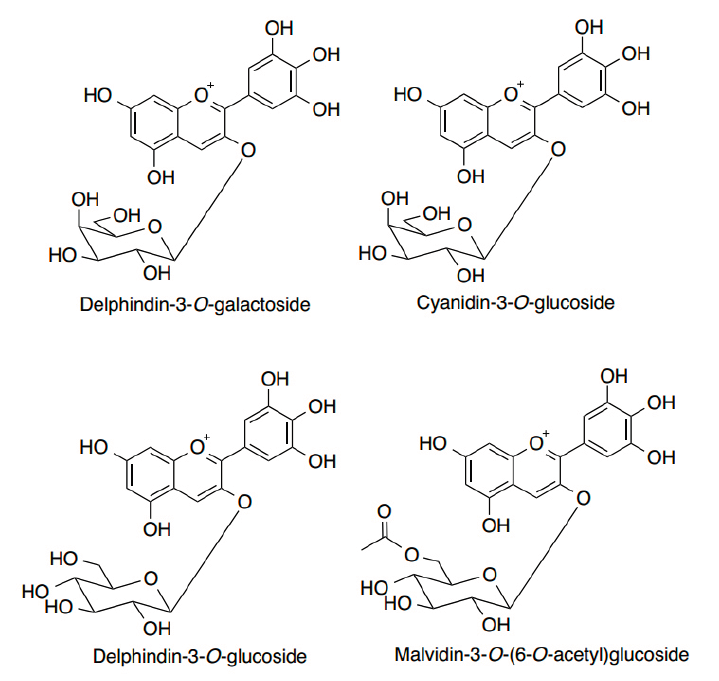
( Vaccinium corymbosum L.). All examples have a sugar moiety at position